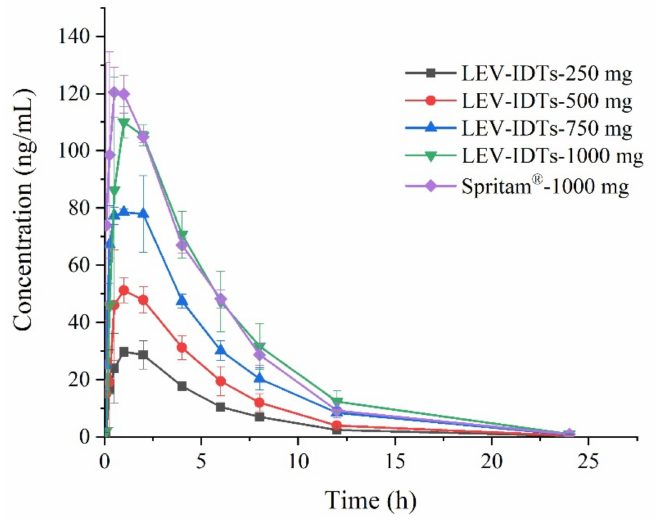
Figure 2. Drug–time profiles after oral administration of LEV in dogs ( n =